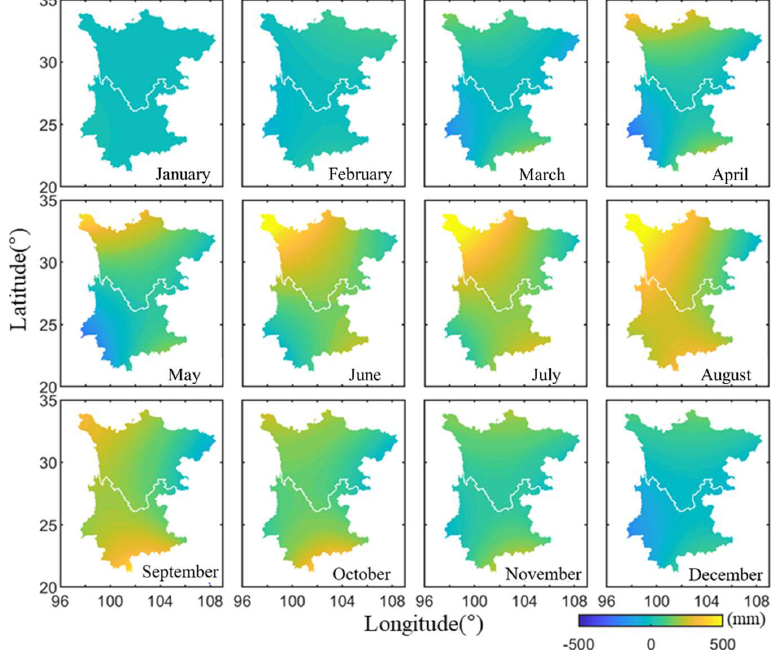
Figure 7. Monthly variations (2011) of the TWS in Sichuan-Yunnan estimated by GPS after removing the ATML and NTOL.